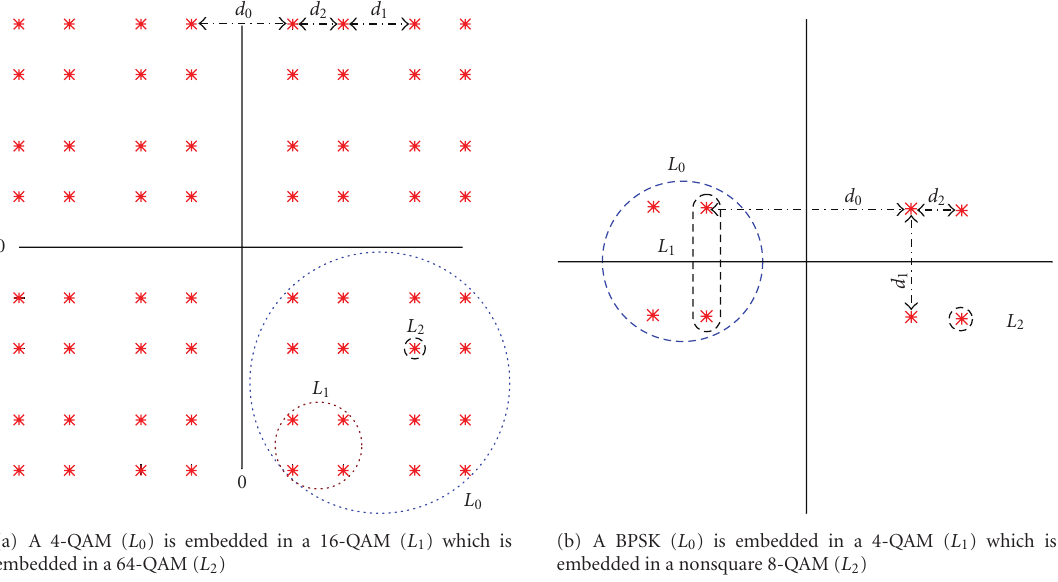
Figure 1: Hierarchical quadrature amplitude modulation (QAM): (a) 4/16/64-QAM and (b) 2/4/8-QAM.